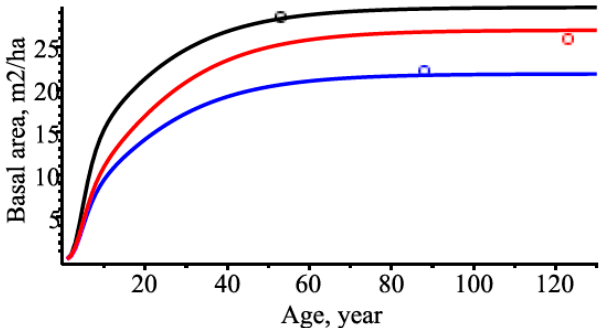
Figure 6. Dynamics of stand basal area over time for the mixed-effects scenario model: solid line, mean stand basal area curves; the first stand, black; the second, red color; the third stand, blue; circles, observed data points.